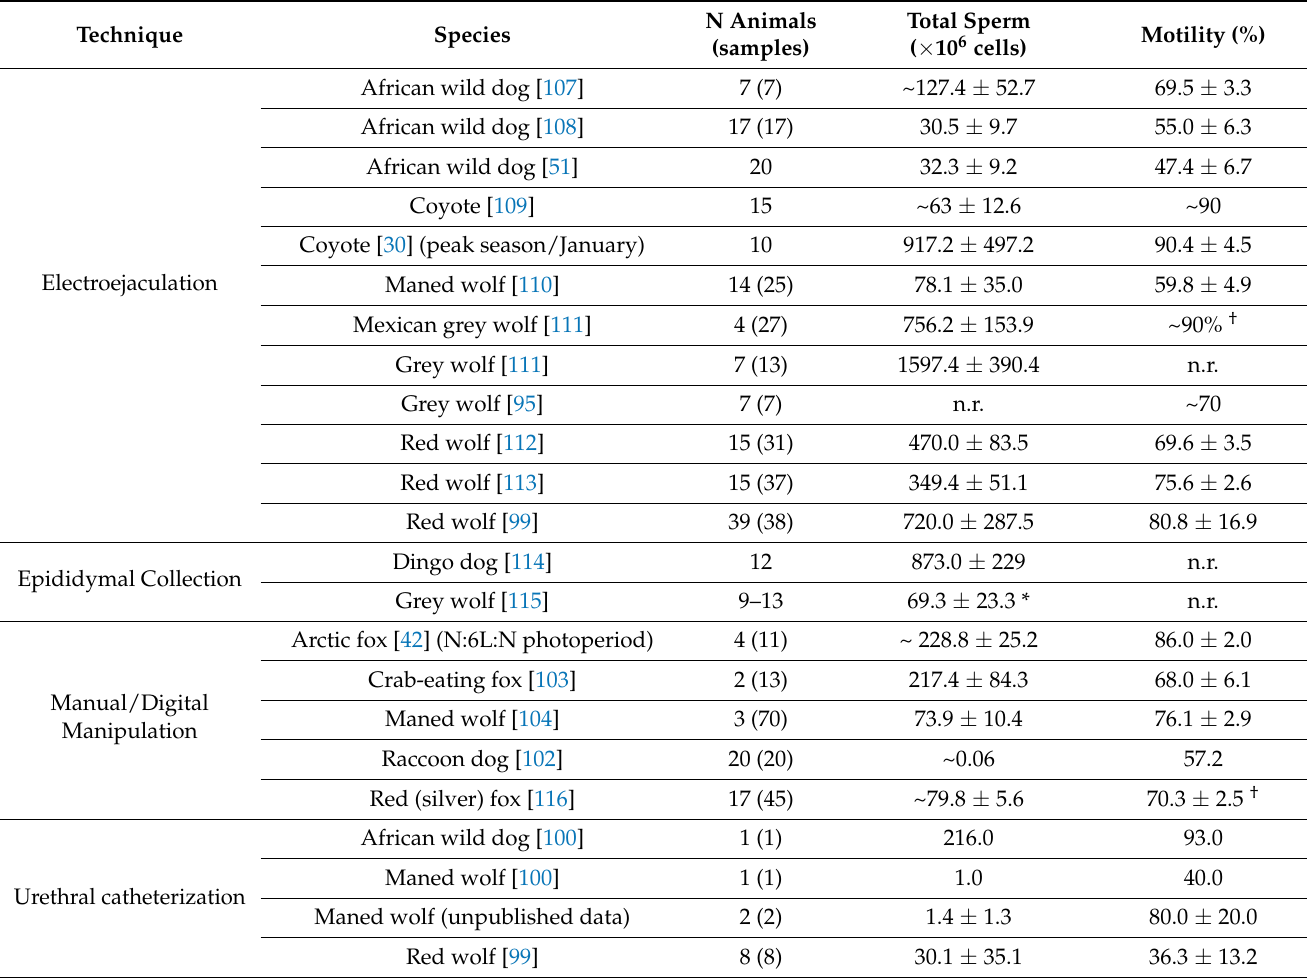
Table 2. Sperm collection methods in wild canid results (Avg ± Standard error of mean). n.r. = not reported.